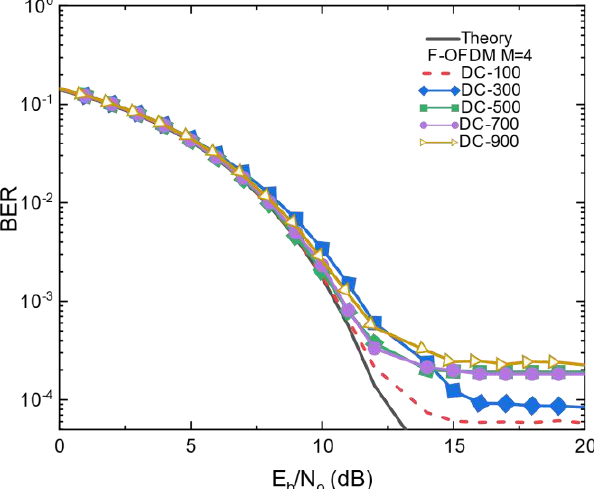
Figure 8. BER performance as a function of E b /N o for F-OFDM with 4-PAM and 200 AC.